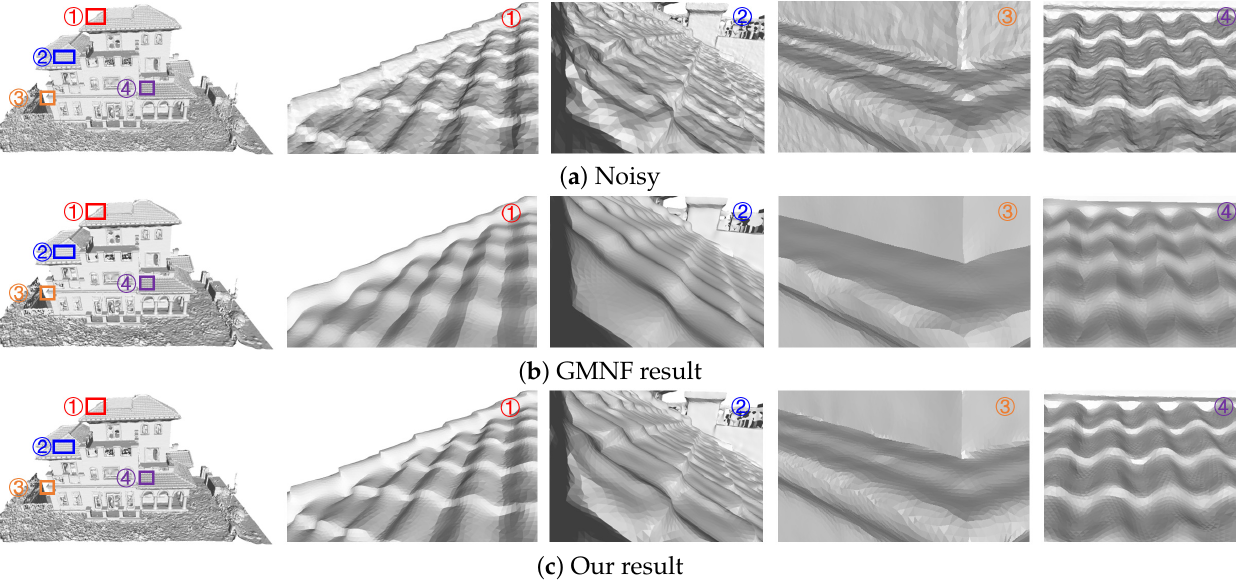
Figure 18. Comparison of the denoising results for the Villa model reconstructed from oblique